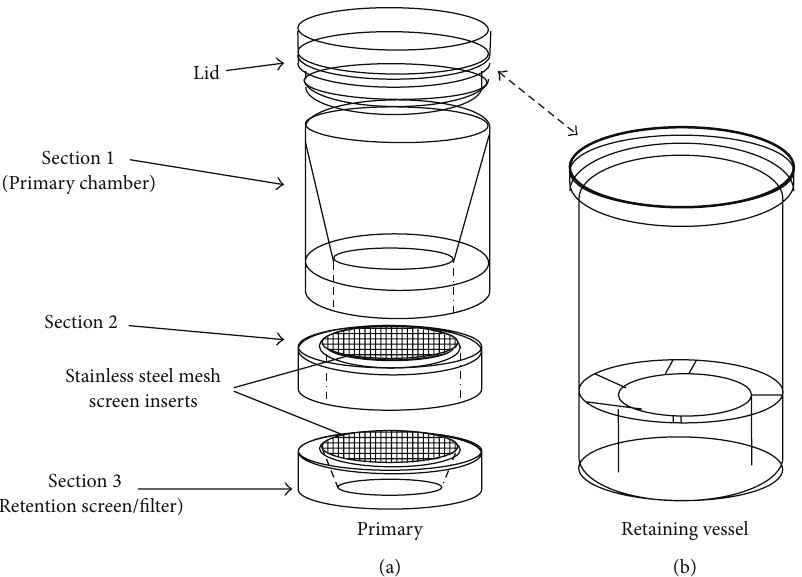
Figure 1: Illustration of centrifugation-filtration device (CFD)